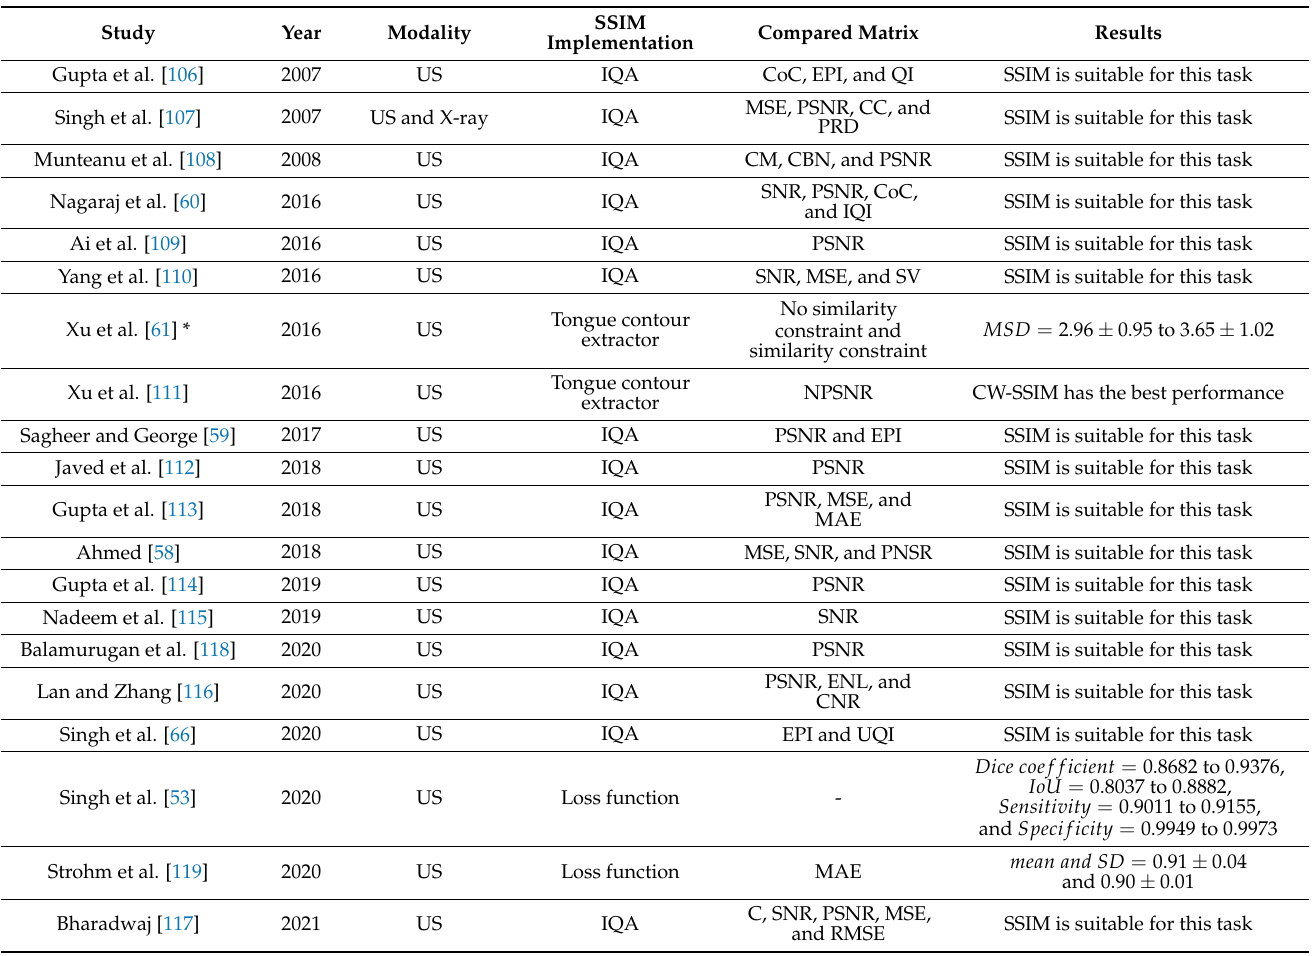
Table 3. Summary of the published articles encompassing SSIM for the US. US, ultrasound; CoC, coefficient of correlation; EPI, edge preservation index; QI, quality index; MSE, mean-square error; PSNR, peak-signal-to-noise ratio; CC, correlation coefficient; PRD, percent rate of distortion; CM, Michelson contrast measure; CBN, Beghdadi and Le N é grate contrast measure; SNR, signal-to-noise ratio; IQI, image quality index; SV, a sum of the variance; MSD, mean sum of distances; NPSNR, normalized peak-signal-to-noise ratio; MAE, mean-absolute error, UQI, universal quality index; ENL, equivalent number of looks; CNR, contrast-to-noise ratio; C, variation of conductance; SNR, signal-to-noise ratio; RMSE, root-mean-square error; IoU, intersection over union; SD, standard